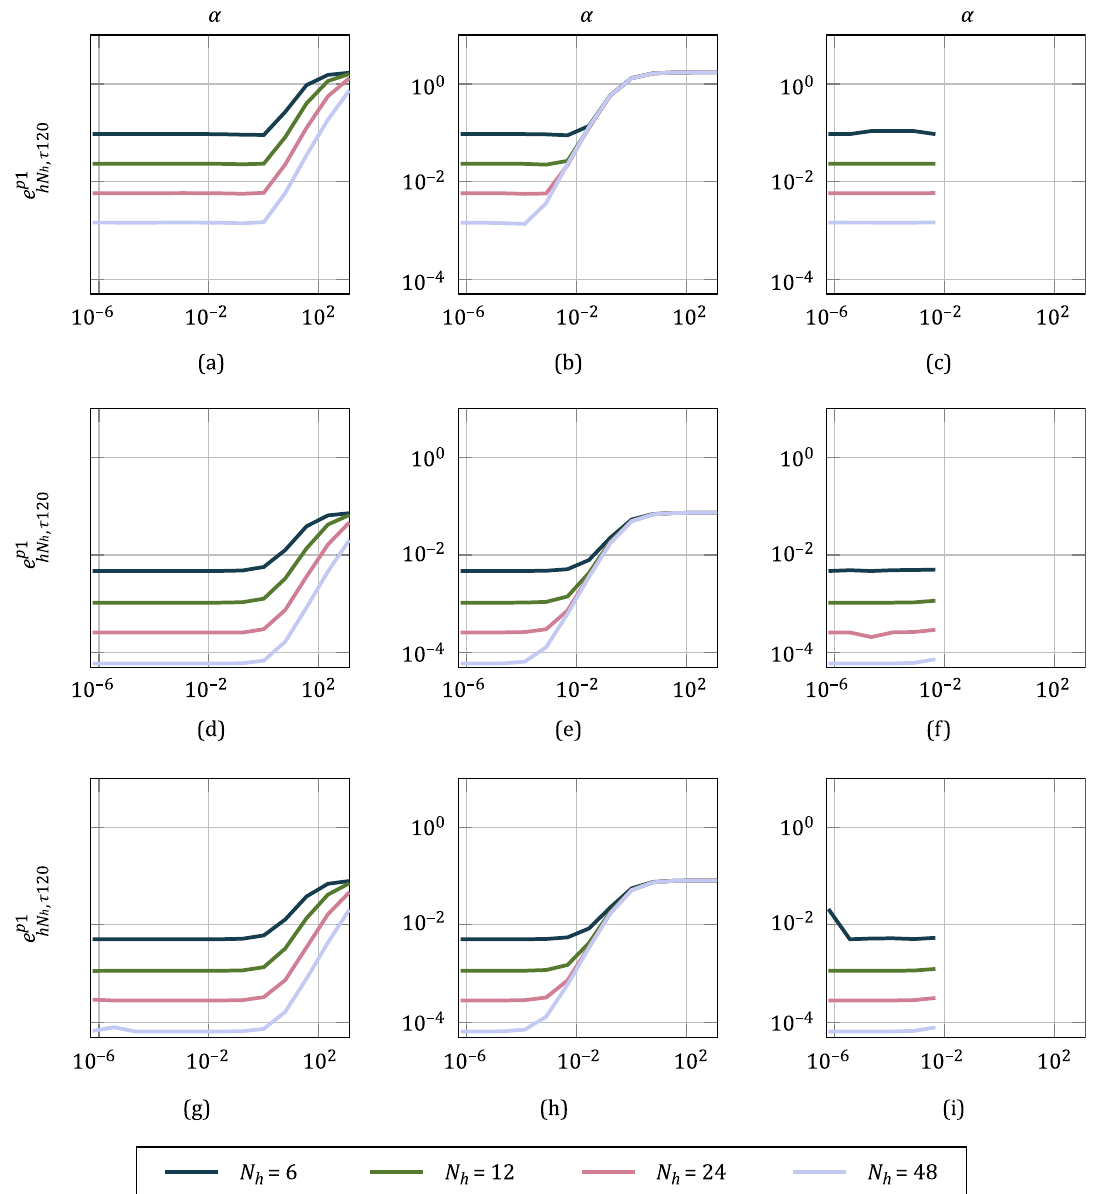
Figure 4. Penalization parameter study, cf. the section Parameter studies for the penalty schemes . The error e p 1 space discretizations N h versus the penalization parameter α for the schemes pena (left), pero (middle), and nits (right). The fi rst row of plots (a – c) corresponds to Test Case 1, the middle row (d – f) to Test Case 2, and the bottom line (g and h) to Test Case